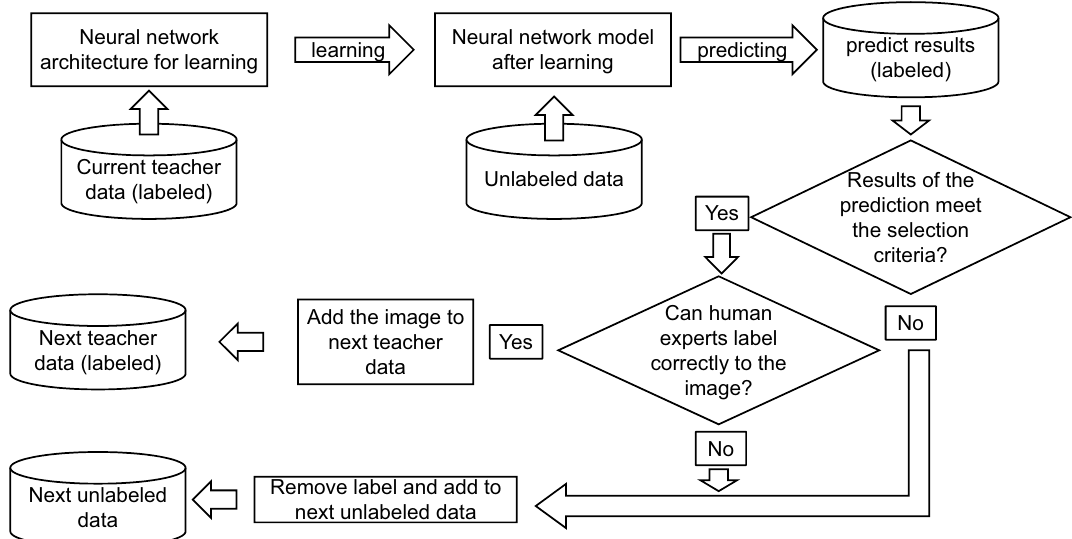
Figure 8. Semi-supervised learning process with the active learning (AL) method. The rectangular frame shows automatic processing by a hand-made program written in Python. The diamond frame shows the automatic judgment by a program written in python. The selection criteria of the difference in prediction provability between the highest and the second highest class was less than 0.2 in this study.